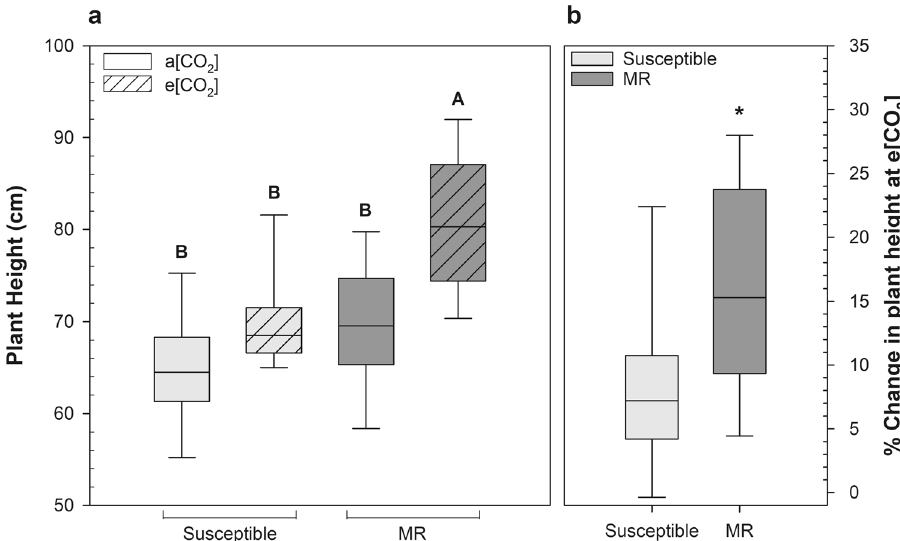
Figure 1. ( a ) Differences in plant height by Fusarium head blight (FHB) resistance at ambient CO 2 (a[CO 2 ]) and elevated CO 2 (e[CO 2 ]). ( b ) Growth response of moderately resistant (MR) and susceptible wheat cultivars at e[CO 2 ], as determined by differences in plant height at a[CO 2 ] compared with the same cultivars grown at e[CO 2 ]. Different letters represent statistically significant differences determined by a Tukey HSD analysis of variance ( P < 0.05); MR ( n = 27), and susceptible ( n = 18), for each CO 2 growth condition. Asterisks (*) denote statistically significant differences ( P <